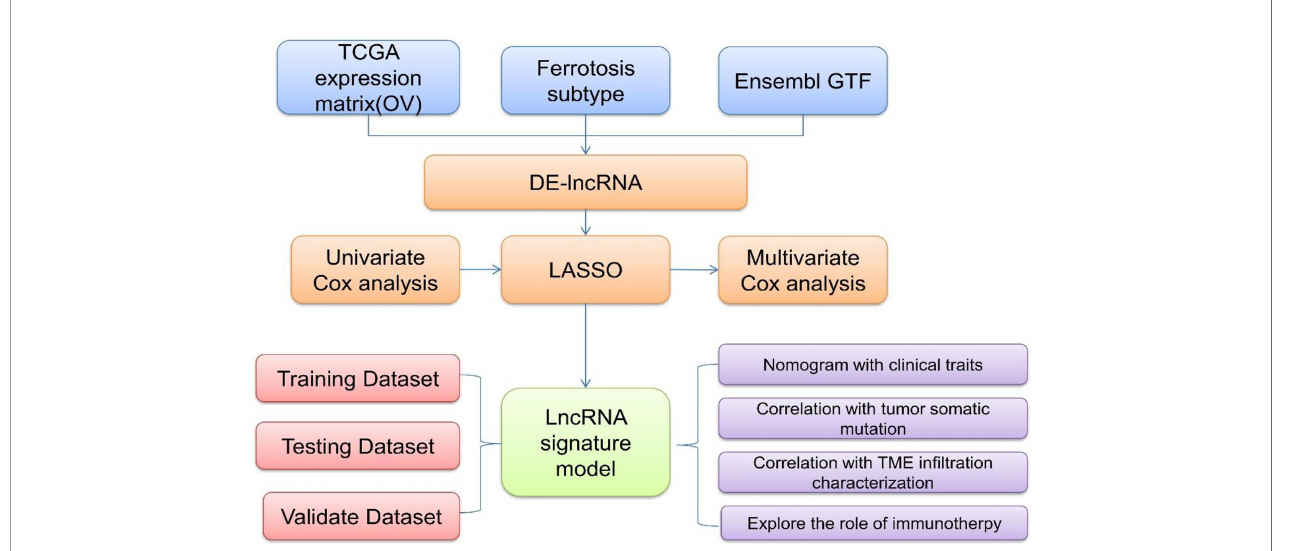
FIGURE 1 | A fl owchart and analysis approaches of this